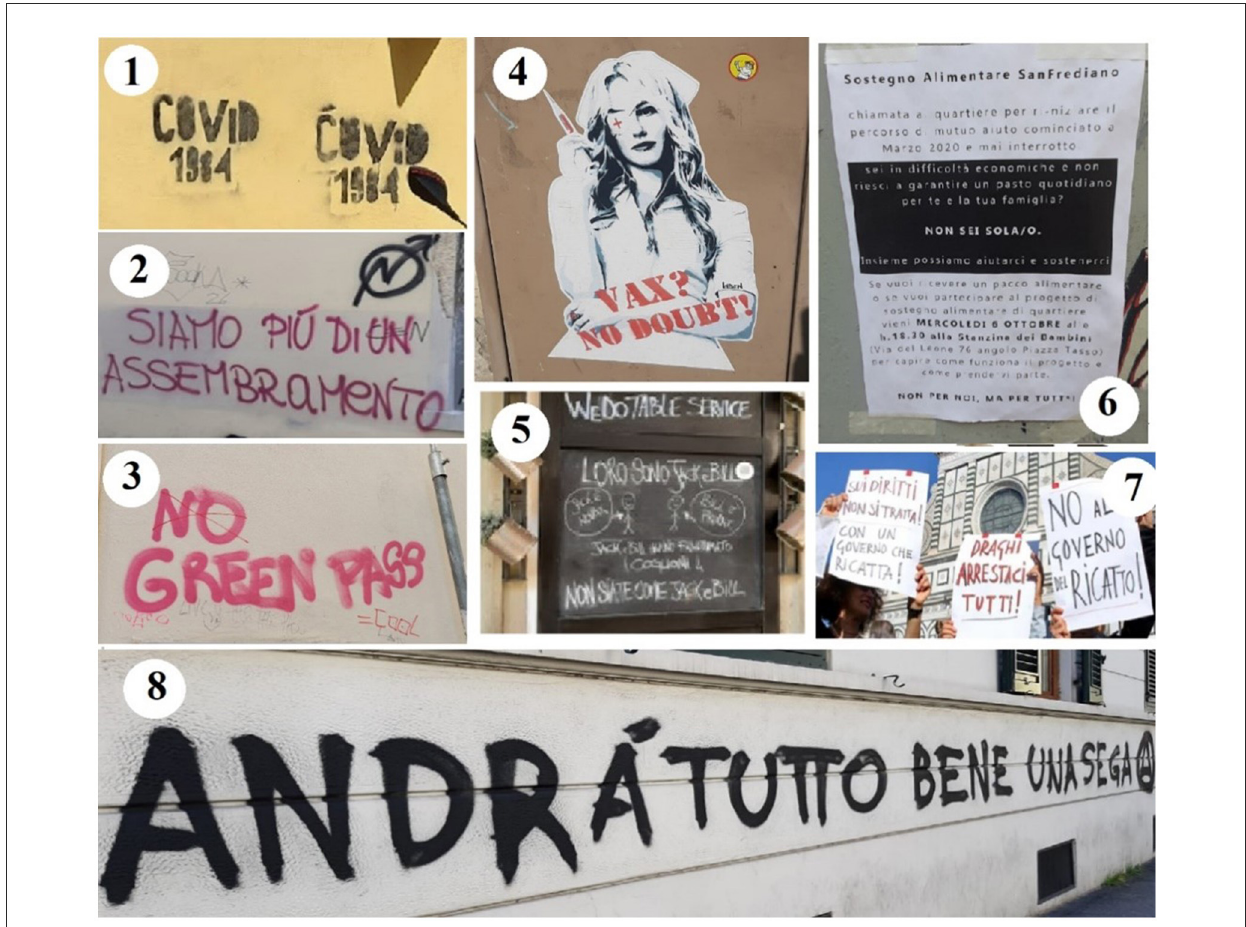
FIGURE4 Photo 1—tag “COVID 1984”; Photo 2—graffiti “we are more than a gathering”; Photo 3—protest, dialogue, and stratification in the LL; Photo 4—stencil art “Vax? No doubt¡‘; Photo 5—meme reworked on blackboard; Photo 6—leaflet for food support; Photo 7—protest signs of a demonstration in the square; Photo 8—graffiti “everything will be all right my